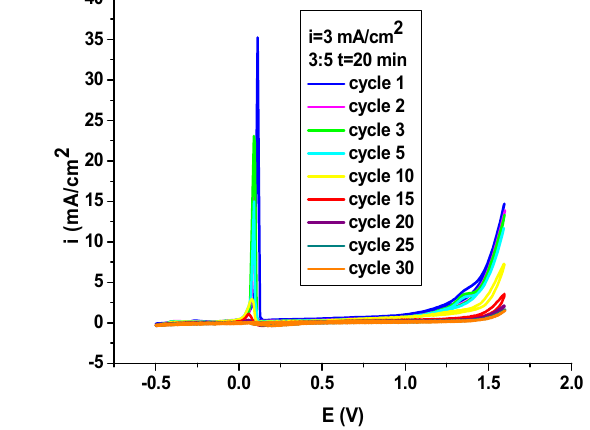
Figure 3. Cyclic voltammograms of OLC 45 electrode coated with PNMPY-TW20/P3MT in 0.3 M H 2 C 2 O 4 solution monomer free at potential interval − 0.5 and 1.5 V vs. SCE and scan rate of 20 mV/s.